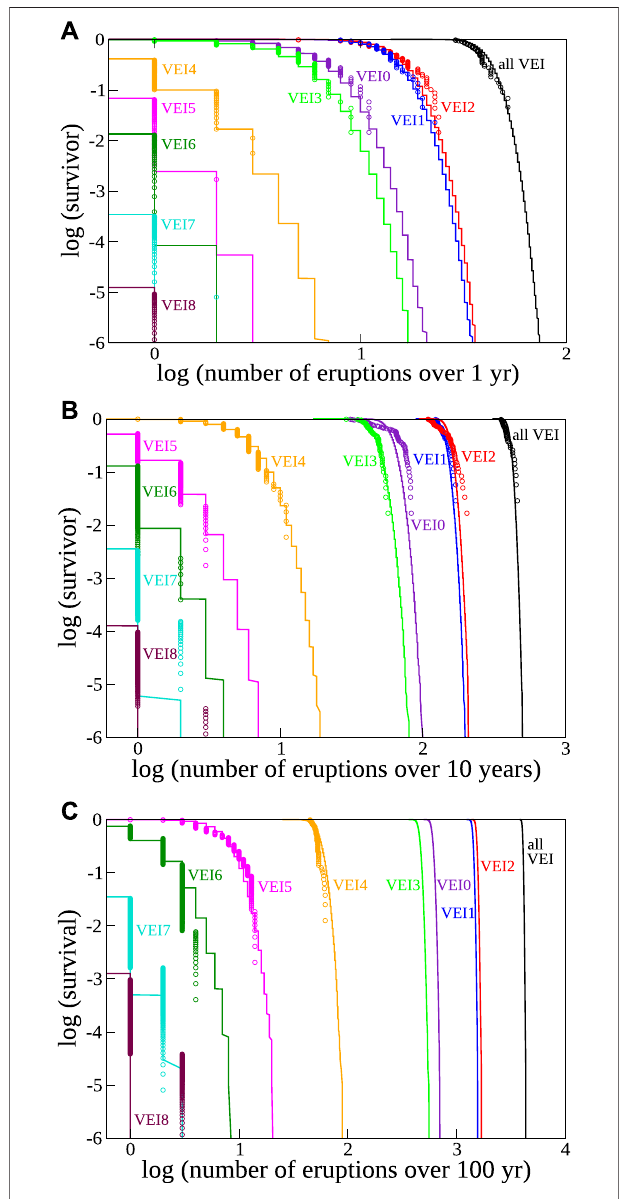
FIGURE 3 | Comparison between computed (lines) and observed (symbols) number of eruptions over different time windows of length 1 (A) , 10 (B) , and 100 (C) years. The step-wise distribution of predictions and observations is due to the integer nature of eruption numbers. Data points are reported for only VEI classes with catalogue completeness at least as long as the considered time window.